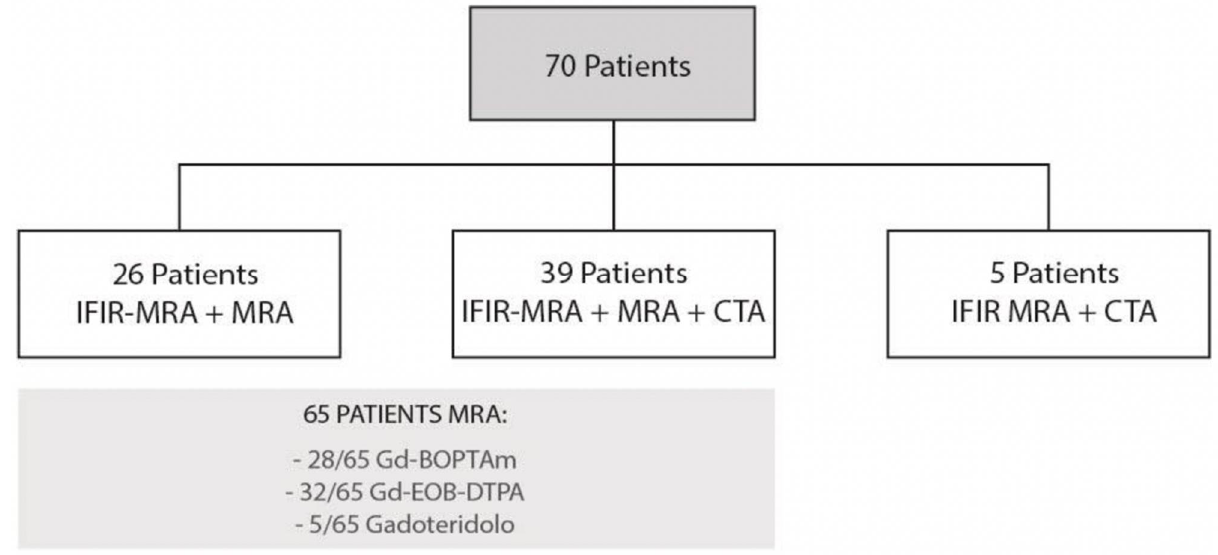
Figure 1. Flow diagram for patient selection.